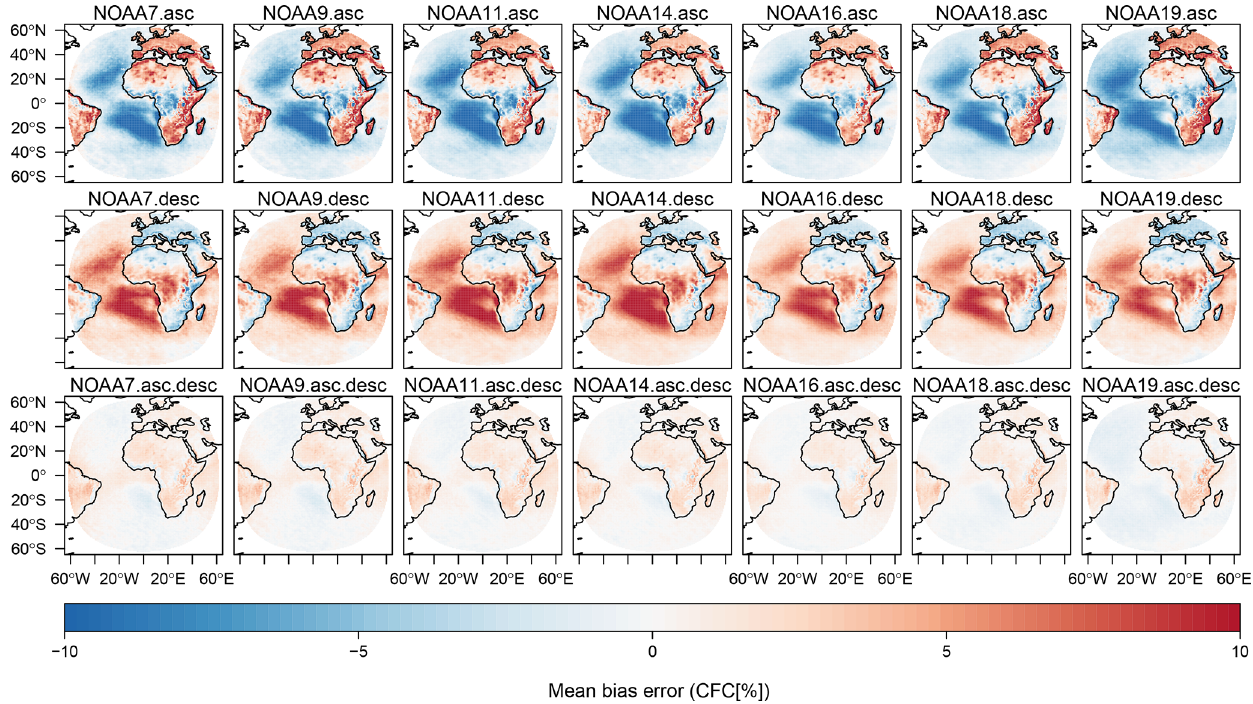
Figure 5. Mean bias error of CFC caused by discrete sampling of CFC diurnal cycle presented for each afternoon (PM) NOAA satellite and each node (asc – ascending, desc – descending, and asc.desc – ascending and descending combined).